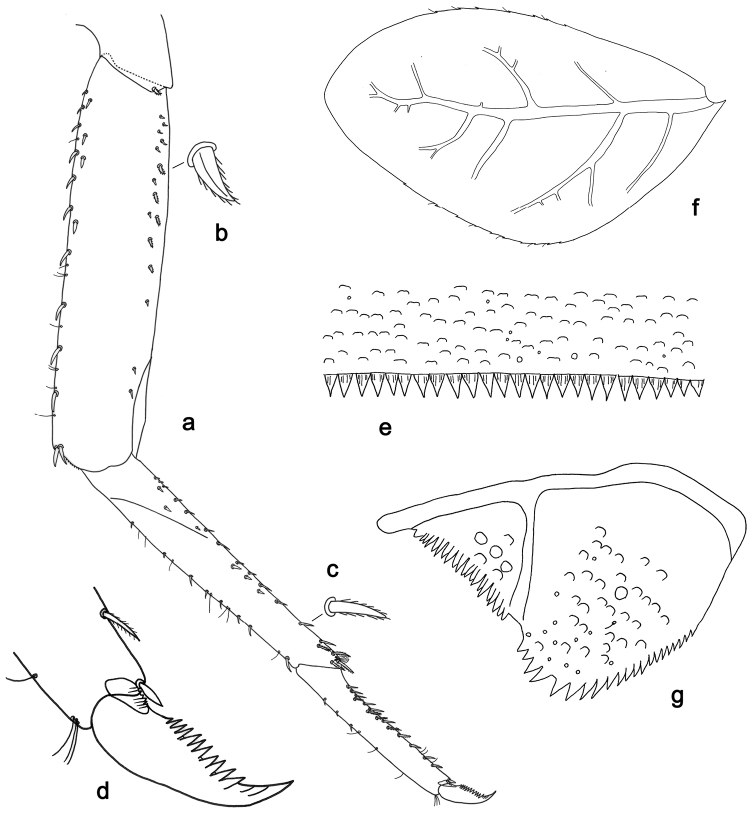
Labiobaetisvallus sp. n., larva morphology: aForelegb Femur ventral seta c Tibia bipectinate seta d Fore claw eTergum IV f Gill III gParaproct.